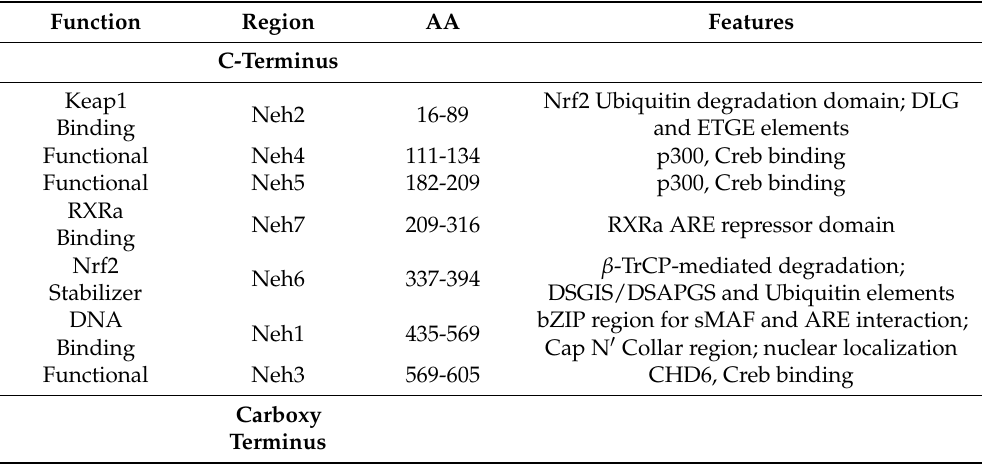
Table 1. Neh regions of Nrf2 and their functions [9–12].